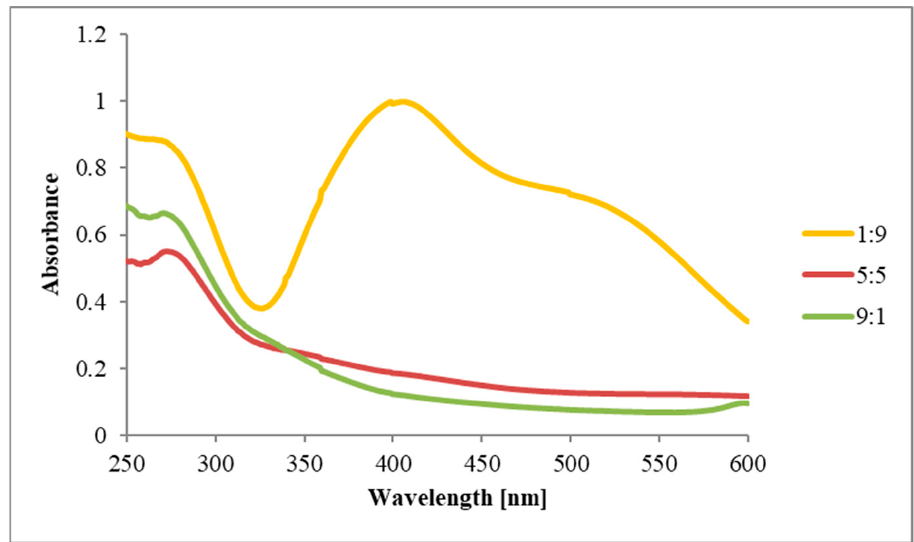
Figure 3. The influence of different plant extract:AgNO 3 ratios (1:9, 5:5 and 9:1) on AgNPs-H 2 O for- The influence of different plant extract:AgNO 3 ratios (1:9, 5:5 and 9:1) on mation. AgNPs-H 2 O